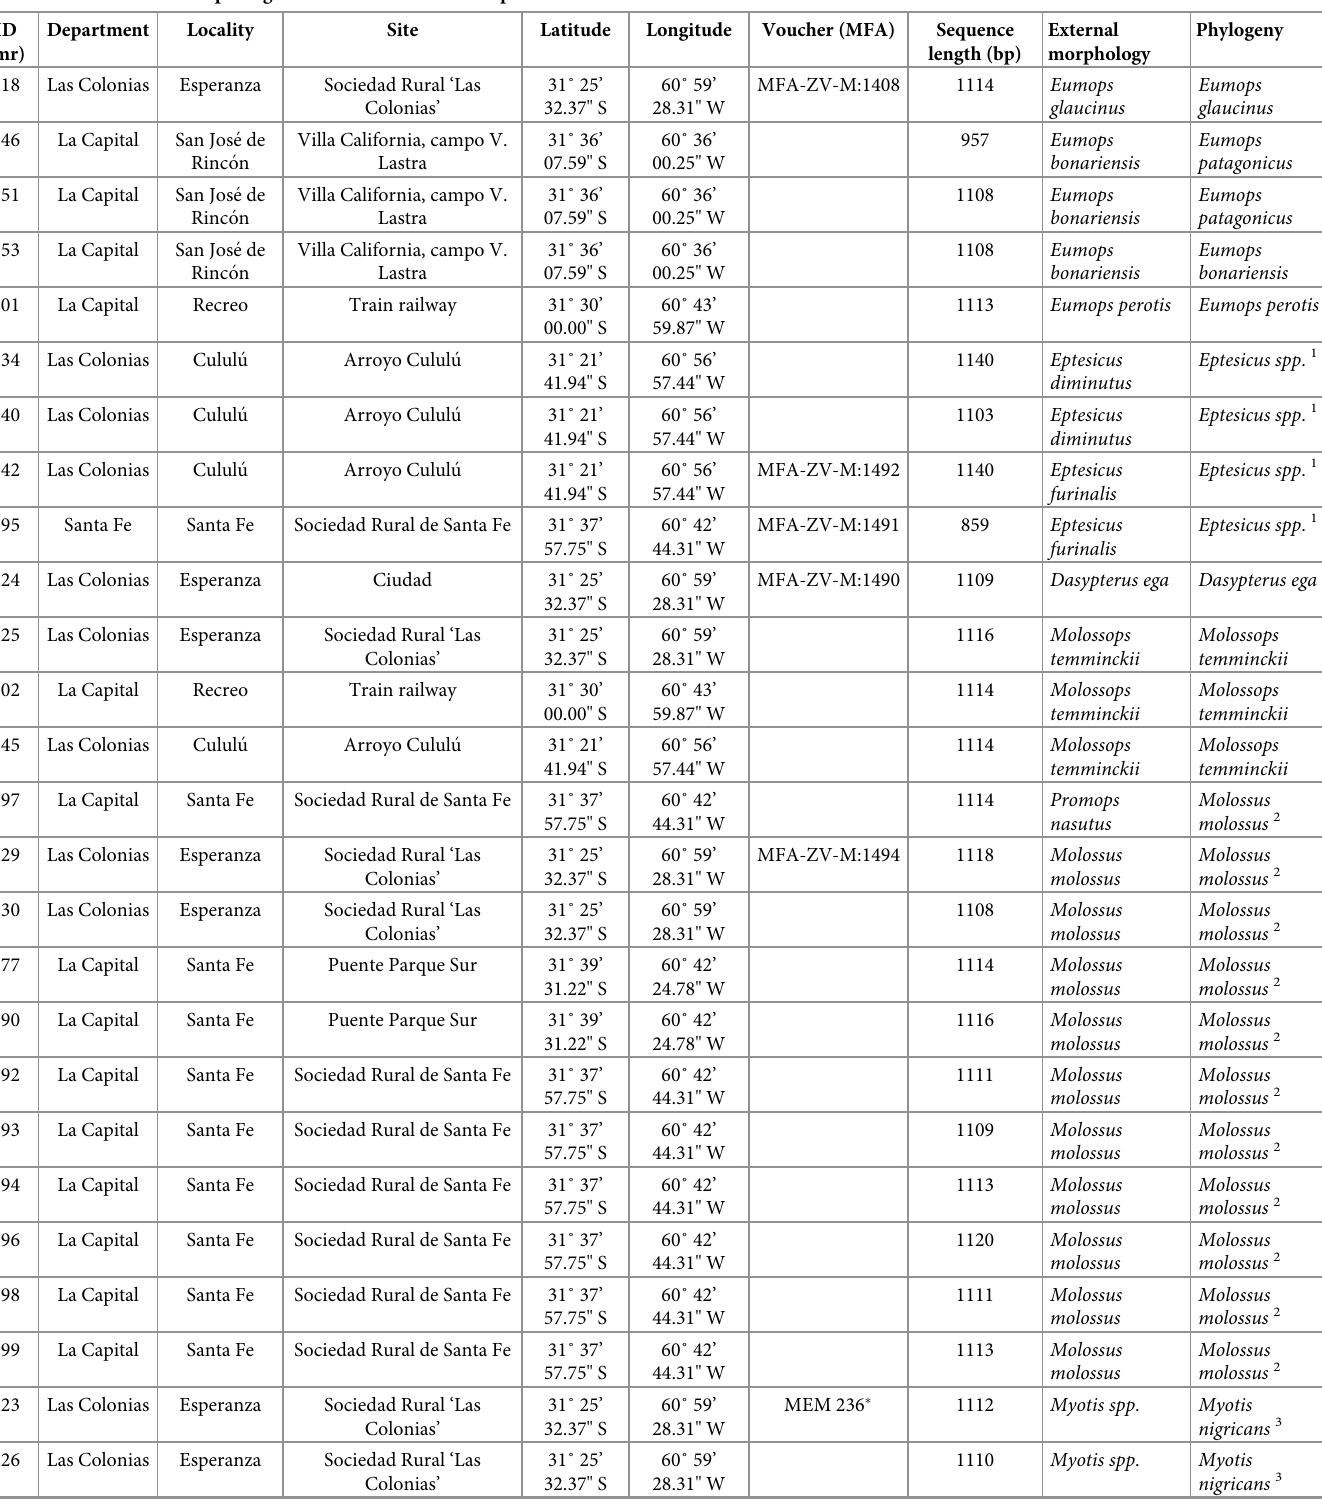
Table 1. Molecular and morphological identification of bats captured in five localities from Santa